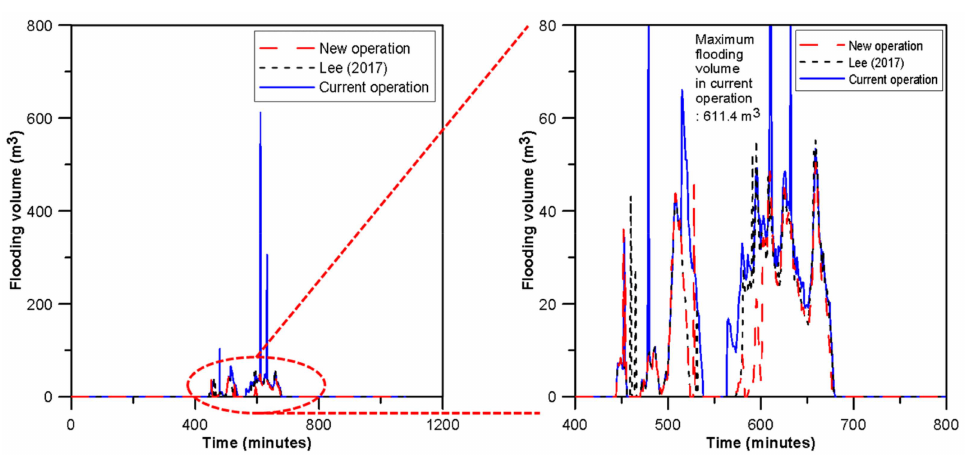
Figure 8. Flooding results of an advanced operation in 2010 [1].